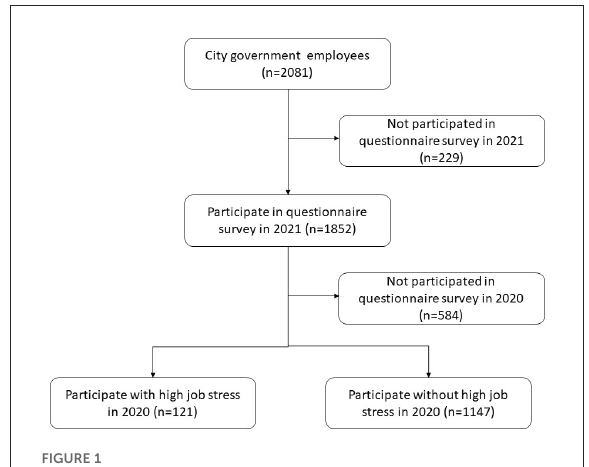
FIGURE1 Flow diagram of the participant selection